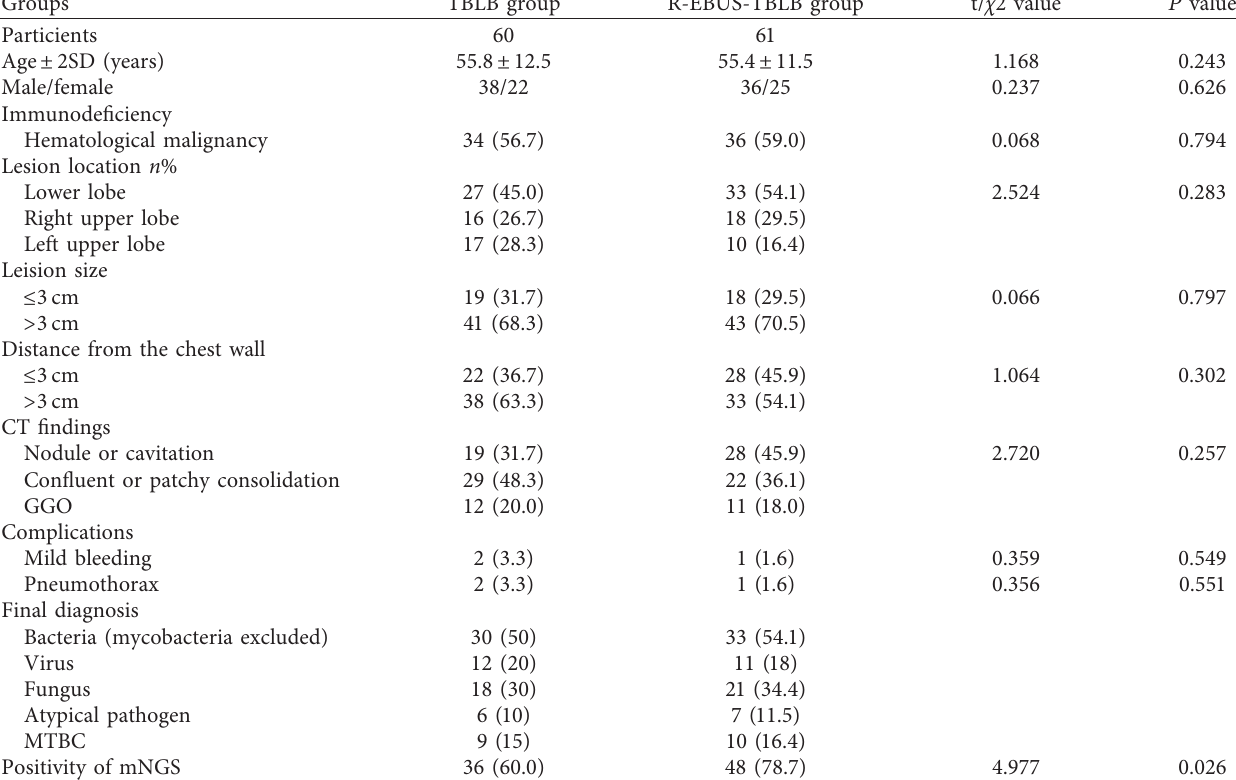
Table 1: Baseline characteristics of study population ∗ .